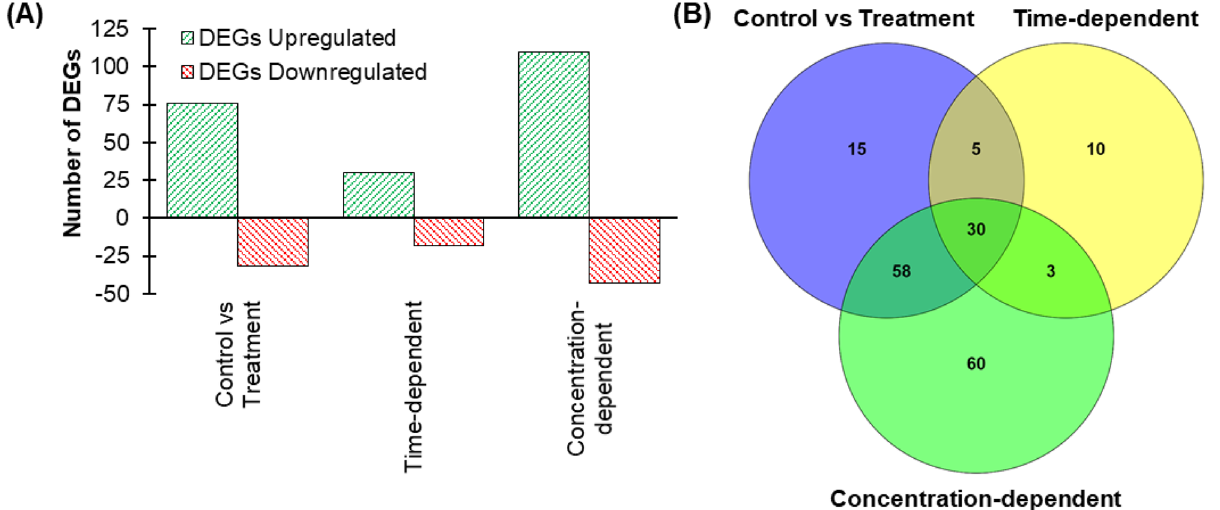
Figure 3. (A) The significantly altered genes in the RNA-seq experiment based on the absolute Z-score ≥ 2 (threshold corrected p-value < 0.05). (B) Venn diagram showing the number of genes and their co-existence in different experimental